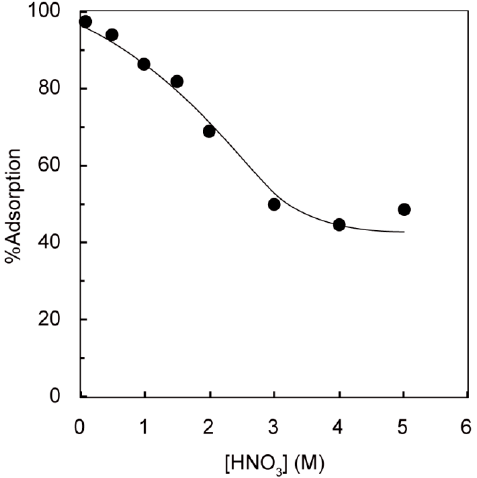
Figure 2. Effect of HNO 3 concentration on the recovery of Ag(I) using the DTO ‐ microalgae. Conditions: Ag(I) concentration = 0.2 mM, weight of adsorbent = 10 mg, volume of test solution = 10 mL, temperature = 30 °C, and shaking time = 24 h.